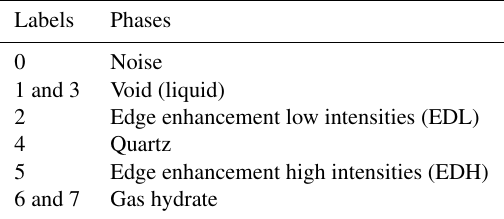
Table 1. Class labels of different